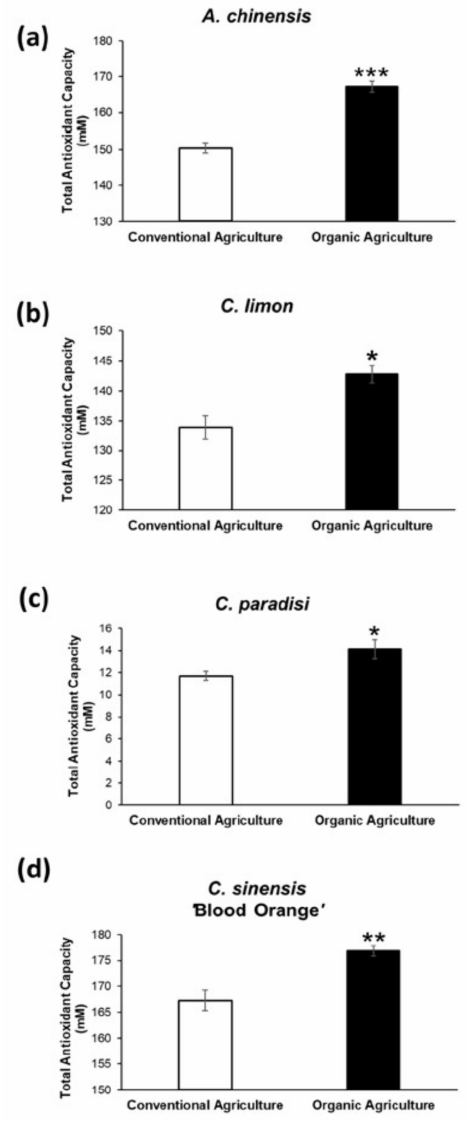
Figure 2. Determination of the Total Antioxidant Capacity (TAC) of organic and conventional agriculture-derived nanovesicles: ( a ) Total Antioxidant Capacity of the nanovesicles isolated from kiwi ( A. chinensis ); ( b ) Total Antioxidant Capacity of the nanovesicles isolated from lemon ( C. limon ); ( c ) Total Antioxidant Capacity of the nanovesicles isolated from grapefruit ( C. paradisi ); ( d ) Total Antioxidant Capacity of the nanovesicles isolated from blood orange ( C. sinensis ‘Blood Orange’). Data are expressed as the mean ± SE. *: p < 0.05; **: p < 0.001; ***: p <